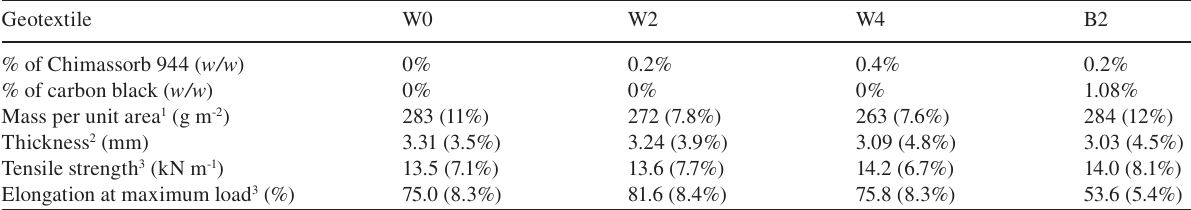
Table 1 Main characteristics of the studied